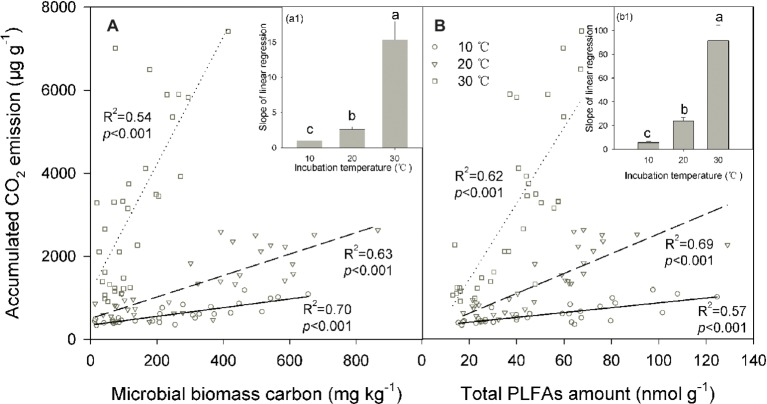
Linear relationship between the accumulated amount of soil CO2 emissions and microbial biomass carbon (A) and the total amount of phospholipid fatty acids [PLFAs (B)] under different incubation temperatures, with the inserted panels A1 and B1 presenting the slopes of linear regressions under the three incubation temperatures. In the figure, the solid lines are regression lines between the two variables observed at 10°C, while the dashed and potted lines are those at 20 and 30°C, respectively. The coefficient of determination R2 and significance level p are presented for each incubation temperature. Different lowercase letters above the bars in the inserted panels A1 and B1 indicate significant differences among the temperatures.